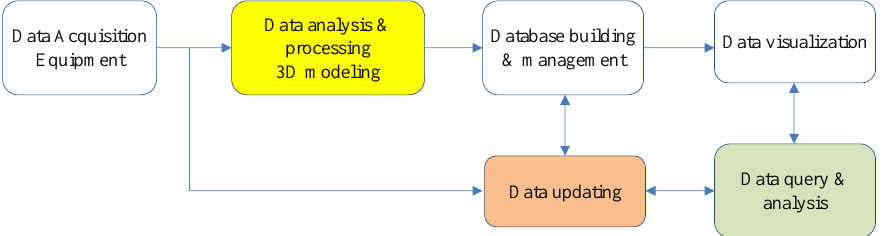
Figure 1. Traditional data processing of a 3D geographic information system